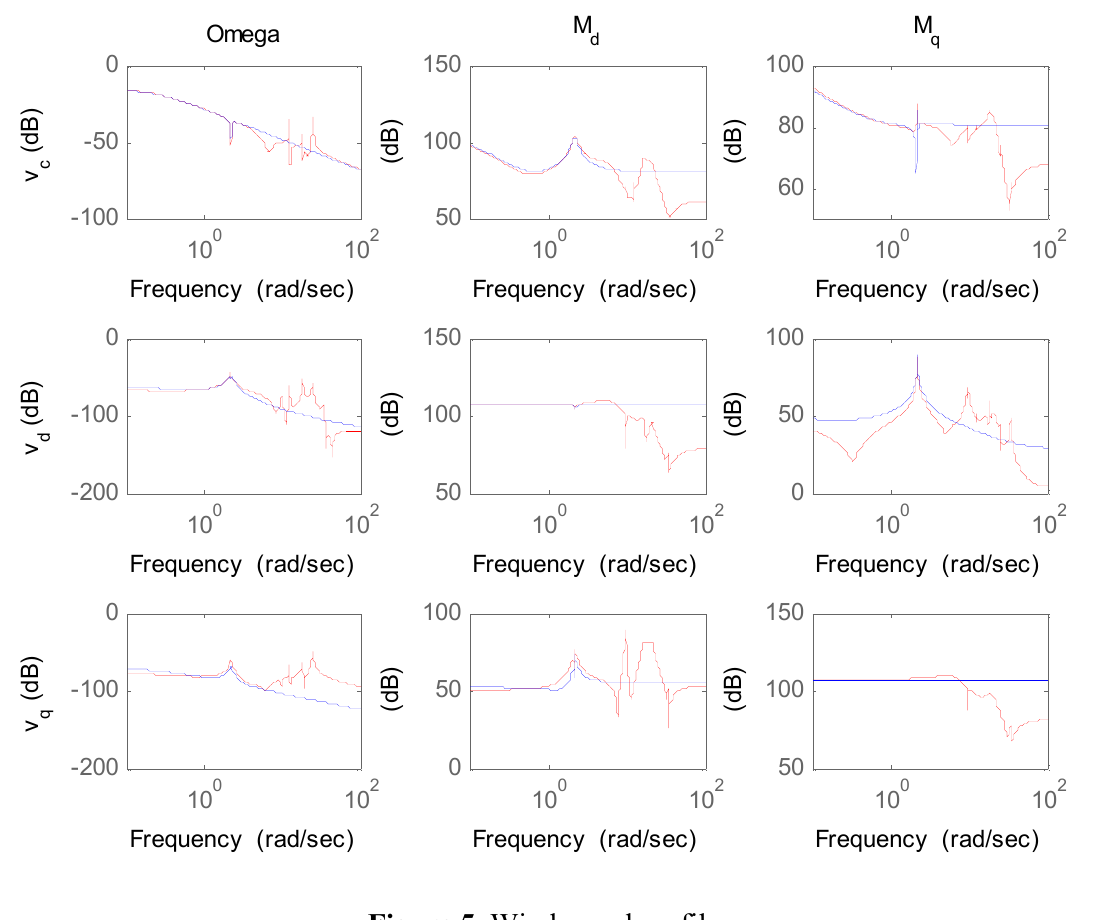
Figure 5. Wind speed